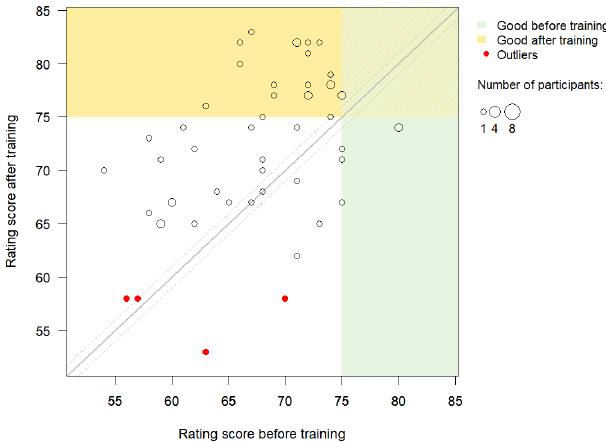
Figure 9. Rating scores before the training ( x axis) and after the training ( y axis). The circle size indicates the number of participants with the same scores. The green background indicates participants who had already performed well (score ≥ 75) before the training, and the yellow background indicates participants who performed well after the training (score ≥ 75). The solid grey line indicates the 1 : 1 line (i.e., the same score before and after the training), while the dashed lines indicate a difference of only one point. Points in the upper-left triangle indicate an improvement in the rating score after the training. The red circles indicate